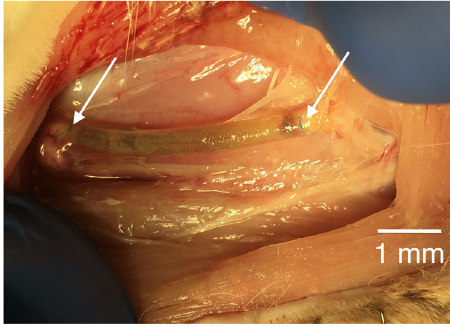
Fig. 4 The cylindrical guide (conduit) exposed at retrieval; not- resorbable suture are visible